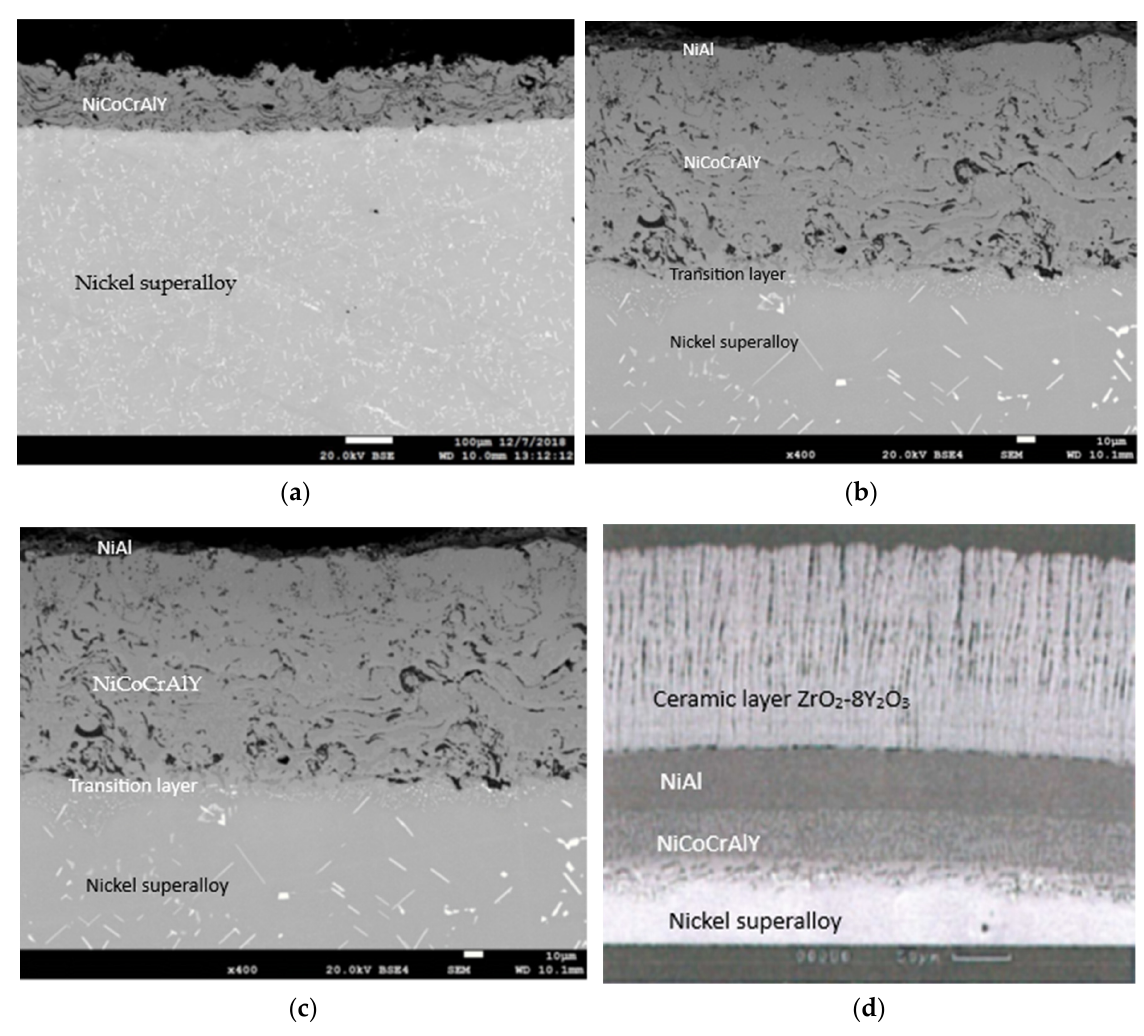
Figure 4. An example of the microstructures of the protective coatings called ( a ) APS, ( b ) APS+VPA, ( c ) APS + SLURRY, ( d ) and APS + TBC after their heat and mechanical treatment.